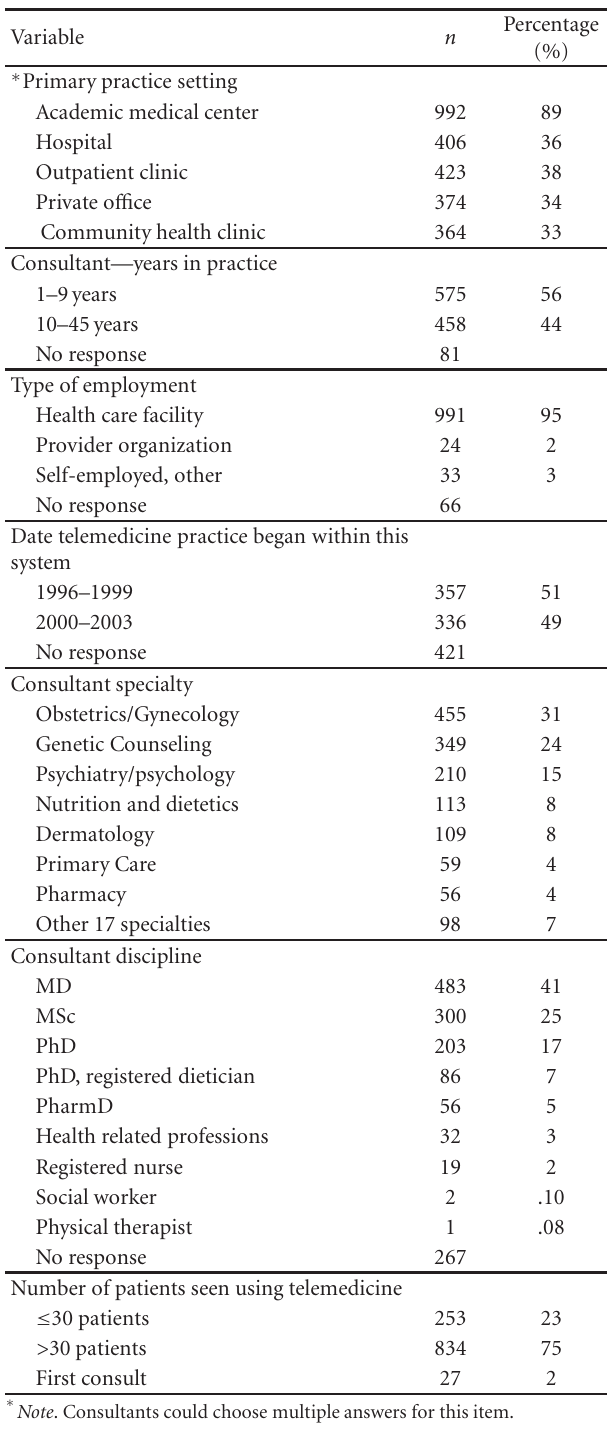
Table 2: Characteristics of the Teleconsultants in the Teleconsulta- tions ( n =